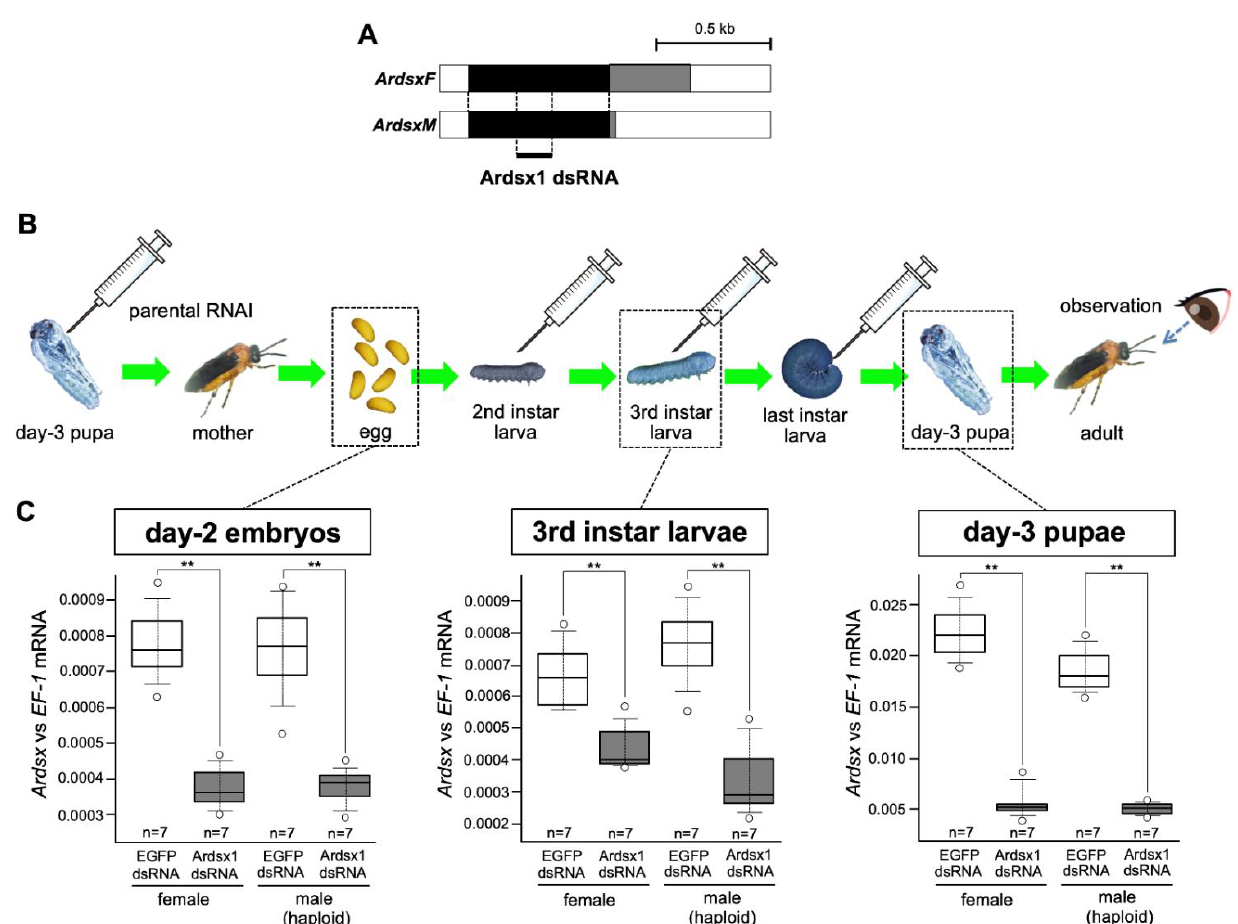
Figure 1. Outline of the RNAi methods used in this study. ( A ) Schematic diagram of the ArdsxF and ArdsxM mRNAs. The white regions indicate untranslated regions (UTRs). The black regions represent the open-reading frames (ORFs) shared between the ArdsxF and ArdsM mRNAs. The gray regions indicate mRNA sequence-encoding sex-specific ORFs. Positions of the dsRNAs targeting Ardsx used in this study are indicated by bold lines. ( B ) Schematic diagram of when and how many times Ardsx1 dsRNA was injected during development and the expected duration of Ardsx -expression knockdown after each round of RNAi. The syringe illustration indicates the timing of the dsRNA injection. ( C ) Effect of the repeated injections of Ardsx1 dsRNA on Ardsx expression. Left panel: The expression level of Ardsx mRNA in the day-2 embryos (three days before hatching), obtained from females injected with dsRNA targeting Ardsx , were determined using quantitative RT-PCR (qRT-PCR). Middle panel: Additional injections of dsRNA targeting Ardsx were performed at the second and the third instar larval stages and the expression level of Ardsx mRNA in the third instar larvae was quantified by qRT-PCR. Right panel: The dsRNA was further injected at the final instar larval stage and the expression level of Ardsx mRNA in the day-3 pupae was determined by the same qRT-PCR. EF-1alpha served as an internal standard (see Materials and Methods). The values shown by each sample and their distributions were represented by box-and-whisker plot. ** Significant difference at the 0.02 level (Mann – Whitney U test) compared with the negative control group, where EGFP dsRNA was injected into animals in the same way.